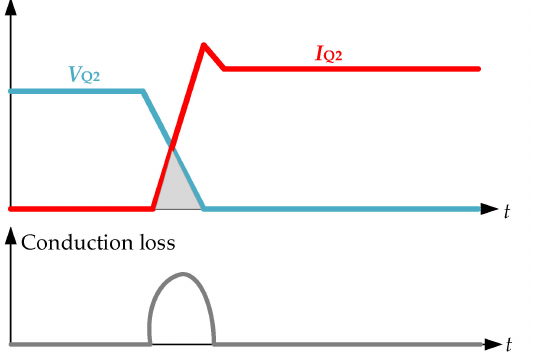
Figure 6. At t 3 , Q 2 is turned on. i p flows from B to A in reverse.